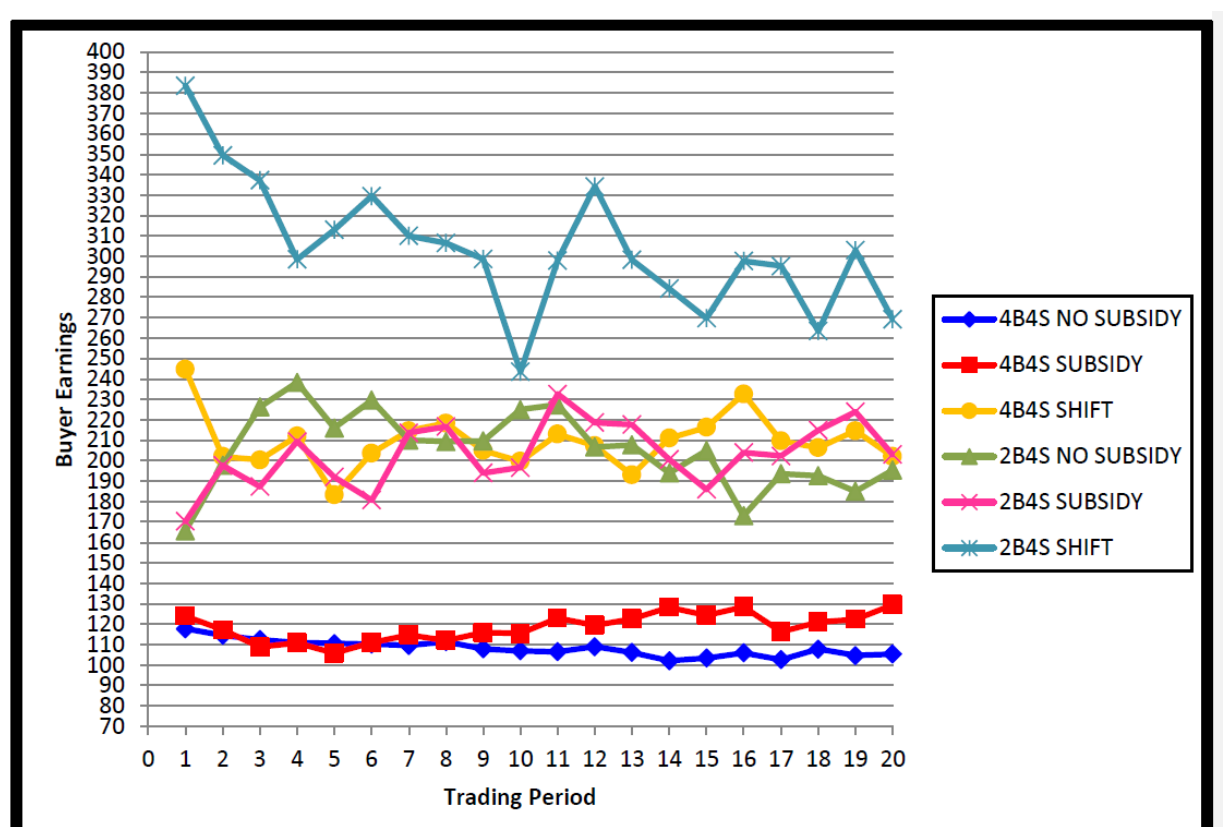
Figure 5. Average buyer earnings per trading period by treatment.